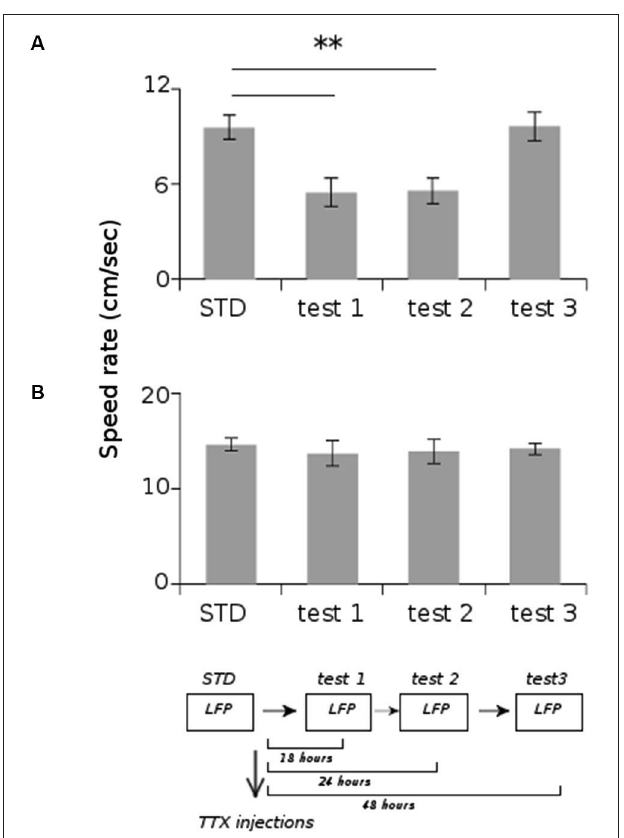
FIGURE 4 | Average locomotion speed rate of the rats during the different recording sessions . (A) Total average speed rate. (B) Average speed rate excluding the periods of immobility (locomotion speed < 5 cm/s). ** p < 0.01, Tukey HSD test.